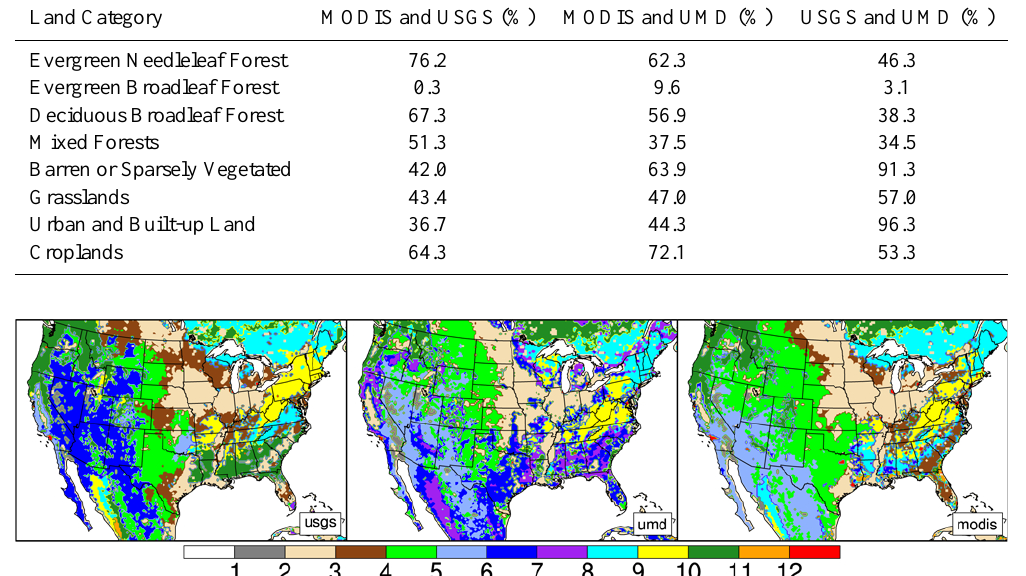
Fig. 1. LULC maps from USGS, UMD, and MODIS. 1 (grey) represents barren or sparsely vegetated land; 2, croplands; 3, cropland/natural land mosaic; 4, grasslands; 5, open shrubland; 6, closed shrubland; 7, woodland; 8, mixed forests; 9, deciduous broadleaf forest; 10, evergreen needleleaf forest; 11, evergreen broadleaf forest; 12 (red), urban and built-up